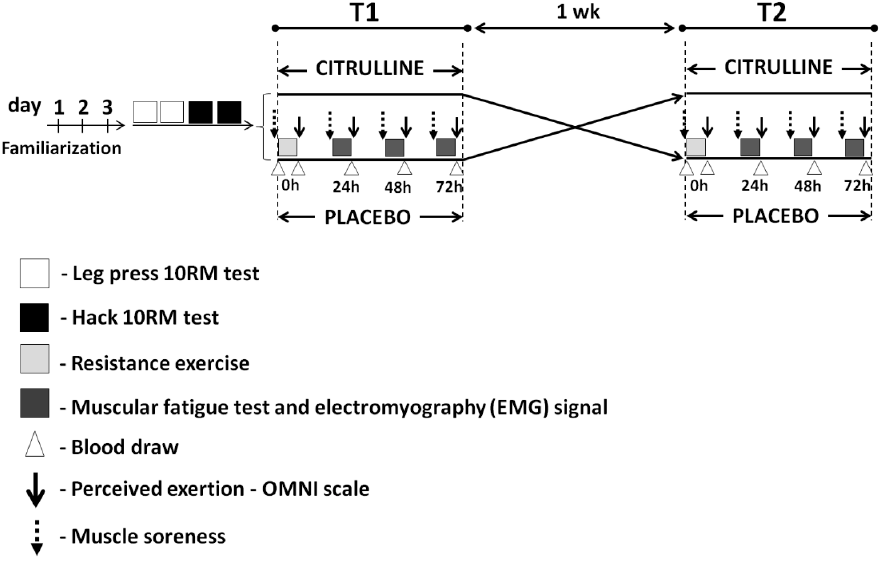
Figure 1. Experimental design.